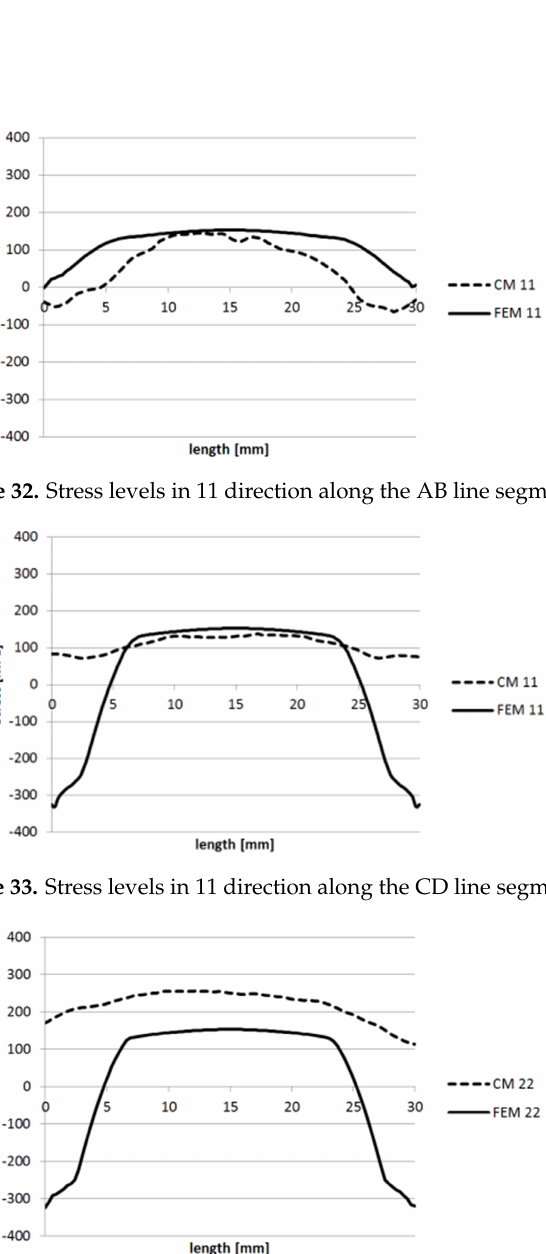
Figure 34. Stress levels in 22 direction along the AB line segment.